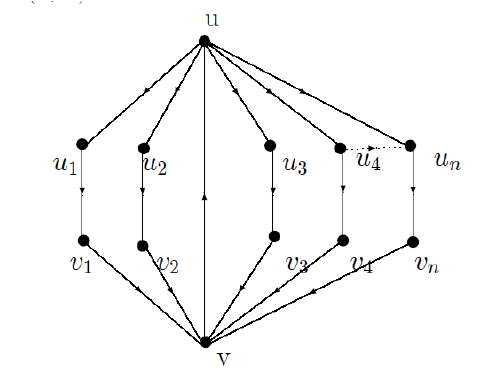
Figure 1.3. Diquadrilateral